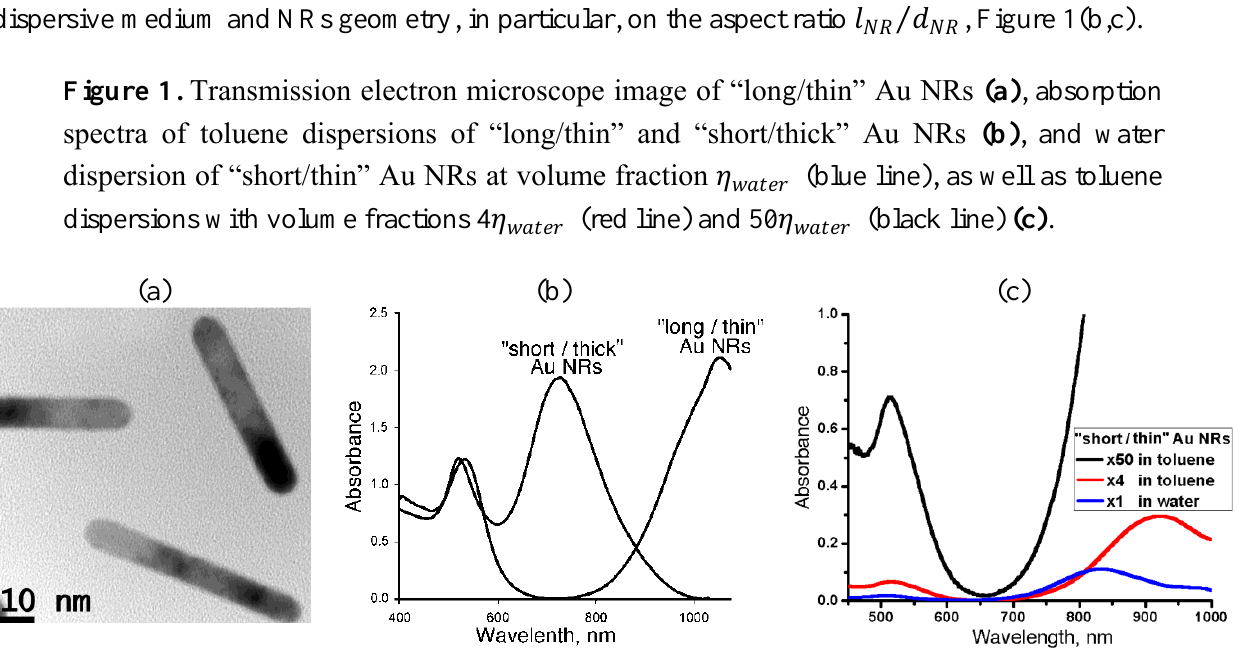
Figure 1. Transmission electron microscope image of “long/thin” Au NRs (a) , absorption spectra of toluene dispersions of “long/thin” and “short/thick” Au NRs (b) , and water dispersion of “short/thin” Au NRs at volume fraction 𝜂 dispersions with volume fractions 4 𝜂